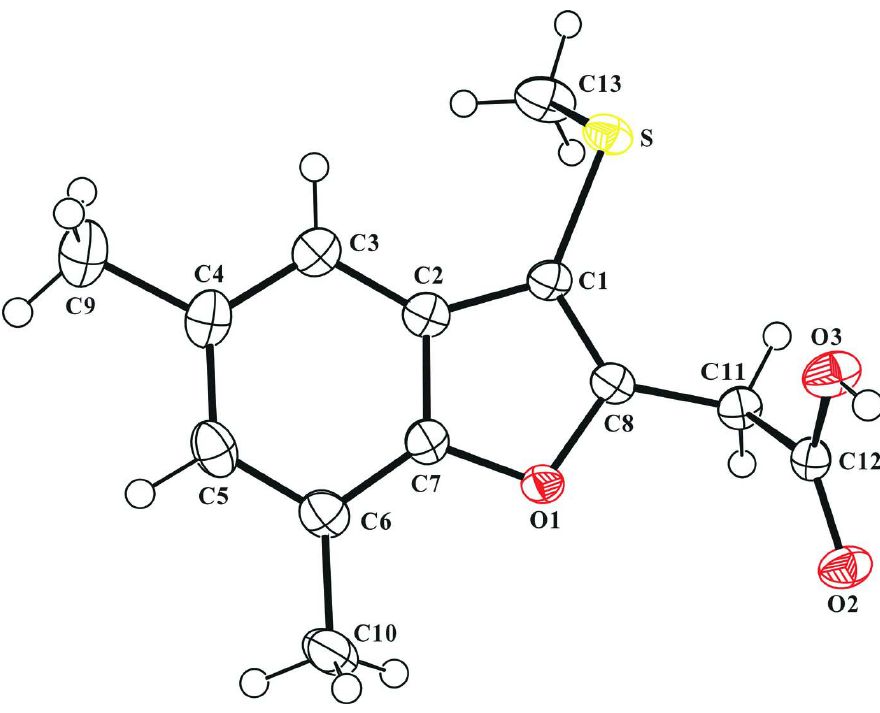
Figure 1 The molecular structure of the title compound, showing displacement ellipsoids drawn at the 50% probability level.